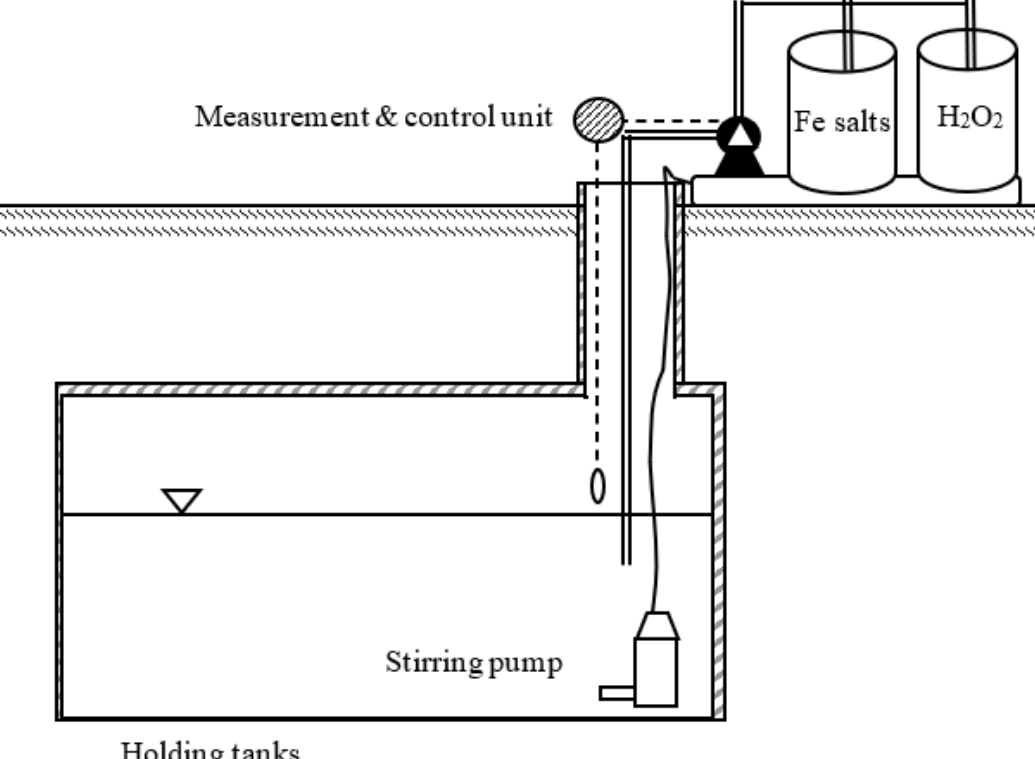
Figure 10. Diagram of the reagent injection system for amending holding tanks.